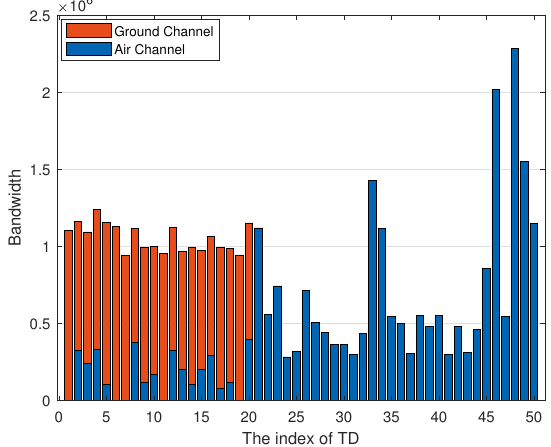
Figure 6. Bandwidth allocation of each